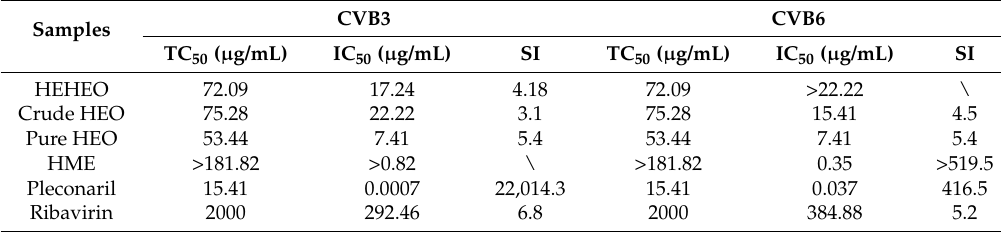
Table 6. In vitro antiviral activities of HEHEO, crude HEO, pure HEO, and HME against CVB3 and B6.